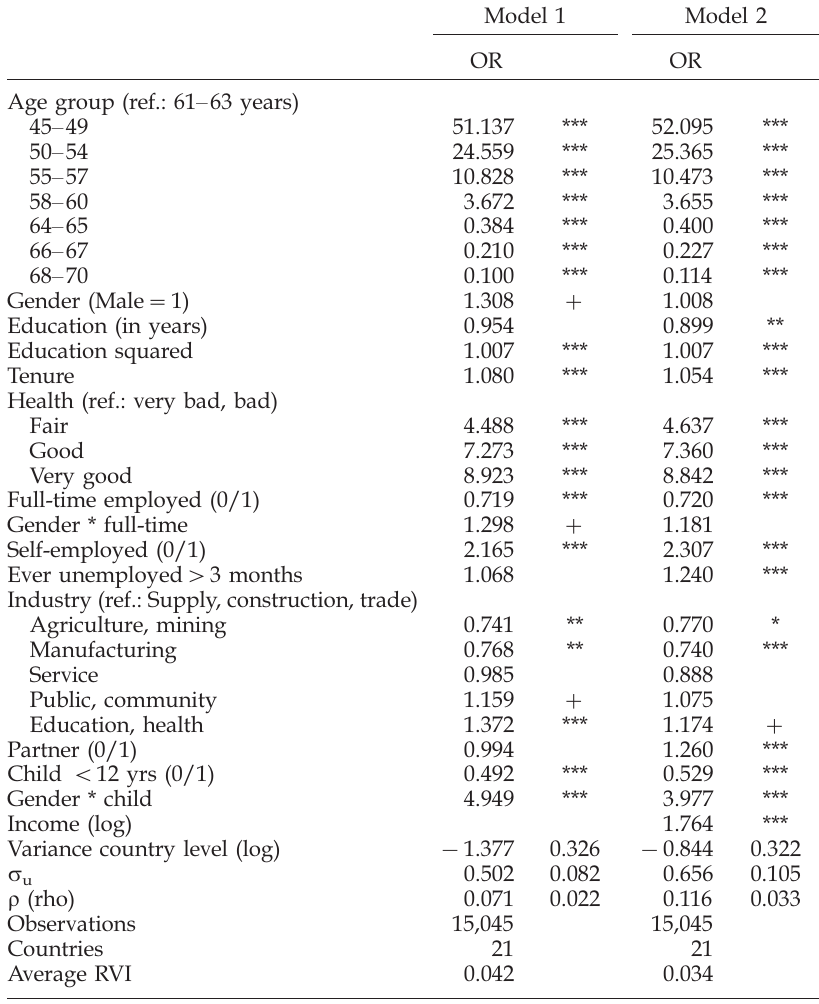
Table 1. Odds ratios, multile v el logistic regression on participation (0/1),